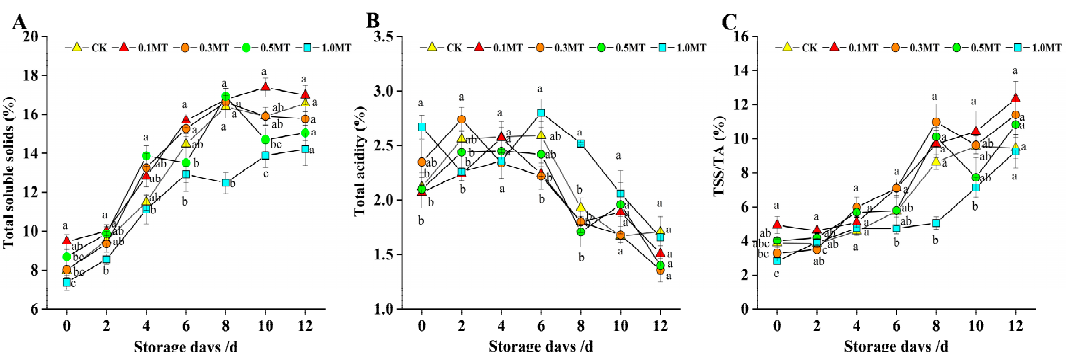
Figure 3. Effect of preharvest melatonin treatment on postharvest kiwifruit total soluble solids ( A ), titratable acidity ( B ), and TSS/TA ( C ). Values indicate the means of the replicates; error bars indicate the standard deviations of the mean (n = 3). Different lowercase letters indicate significant differences between treatments ( p < 0.05), while identical letters indicate no significant differences between treatments ( p > 0.05).